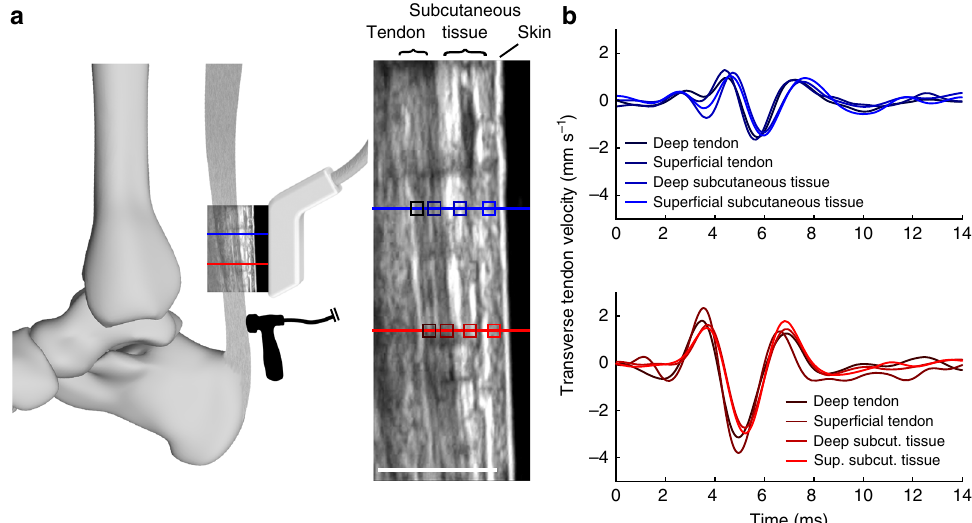
Fig. 2 In vivo ultrasonic measurement of wave speed. a A linear array ultrasound transducer was strapped over the subject ’ s Achilles tendon. High frame rate (14,100 frames per second) ultrasonic radiofrequency (RF) data were collected at two points (red, blue lines). A custom tapper device (hammer icon; see Supplementary Fig. 2), which was located distal to the ultrasound transducer, intermittently induced transverse waves in the tendon. Center: transverse tissue velocity was measured at multiple kernels (indicated by boxes; darker shades indicate greater depth) located along each RF collection line (red, blue). Scale bar, 1 cm. b We observed that transverse motion was similar for all kernels along the fi rst (red, lower) and second (blue, upper) measurement